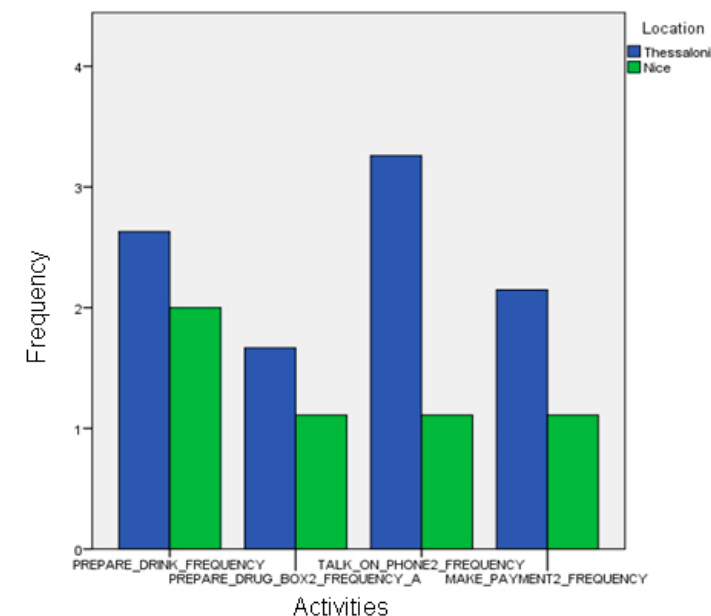
Figure 13. Comparison between the duration of the manually annotated events of different cognitive status groups of the Nice pilot.